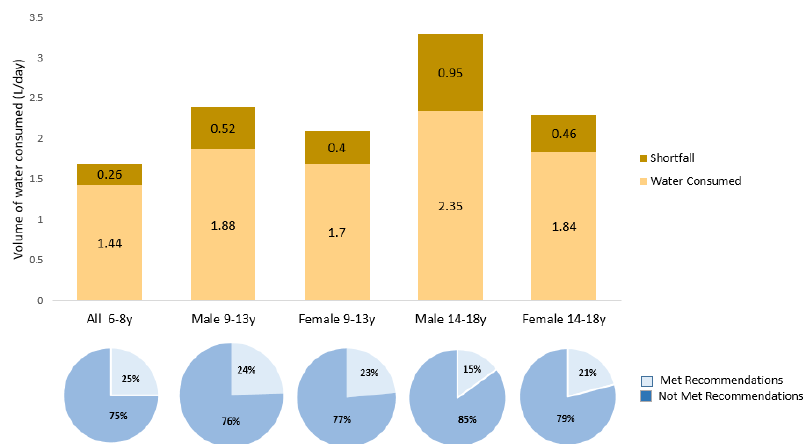
Figure 2. Comparison of water intake between study participants and Institute of Medicine (IOM)